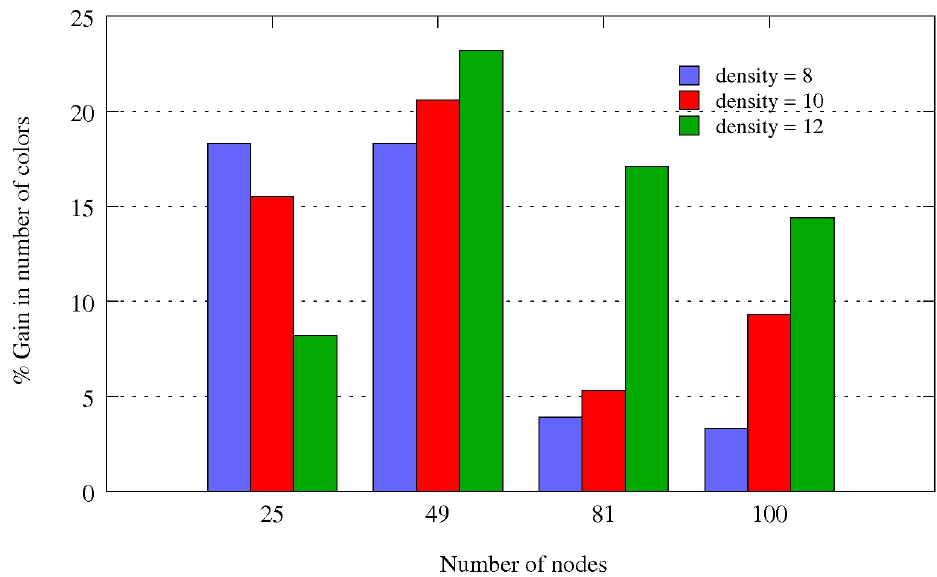
Figure 15. Benefits brought by tree